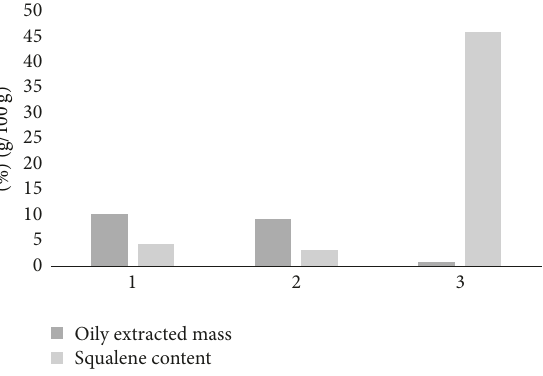
Figure 4: Oily extracted mass in seeds and squalene content in oily extracts (g/100g). (1) Raw seeds hexane extract; (2) puffed seeds hexane extract; (3) puffed seeds SCFE